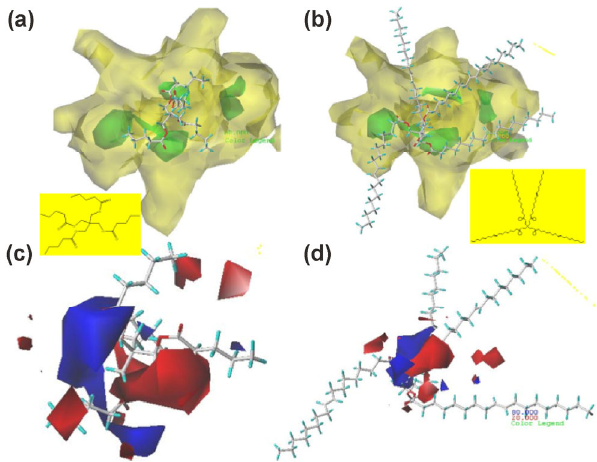
Fig. 3 CoMFA contour diagram for antiwear with embedded D01and D04 as reference for both steric and electrostatic fields. (a) D01, steric; (b) D04, steric; (c) D01, electrostatic; (d) D04, electrostatic. Green and yellow regions show where steric bulk is favored and disfavored, respectively. Blue region shows that positive charge is favored while red region shows that negative charge is